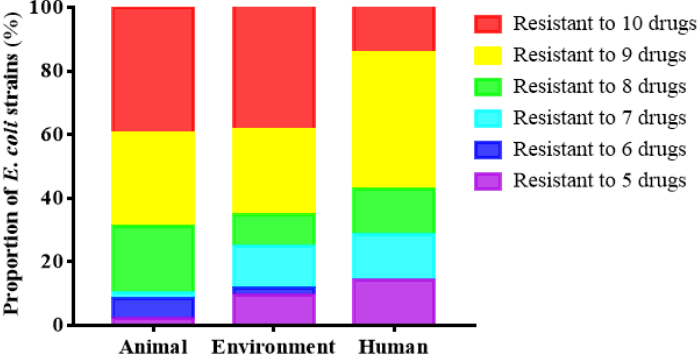
Figure 4. Resistance rates of 107 strains of E. coli from different sources to different antibiotics.